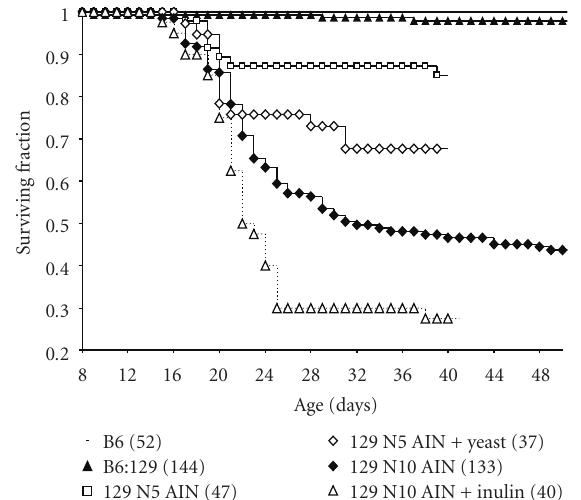
Figure 1: Kaplan-Meier curves showing the e ff ect of genetic background and diet on DKO mouse survival. All mice are on AIN base diets. Monitored from 8 days of age, the surviving fraction excludes dead and culled, moribund mice. The numbers in parenthesis are the number of mice in each group. The data for yeast are pools both 1 and 10% as no di ff erence could be distinguished. There are log rank di ff erences for all interstrain comparisons on AIN diet: P < . 0001. 129 N5, yeast-supplemented AIN (AIN + yeast) diet versus AIN; P = . 0087. 129 N10, inulin-supplemented AIN (Ain + inulin) diet versus AIN; P = .